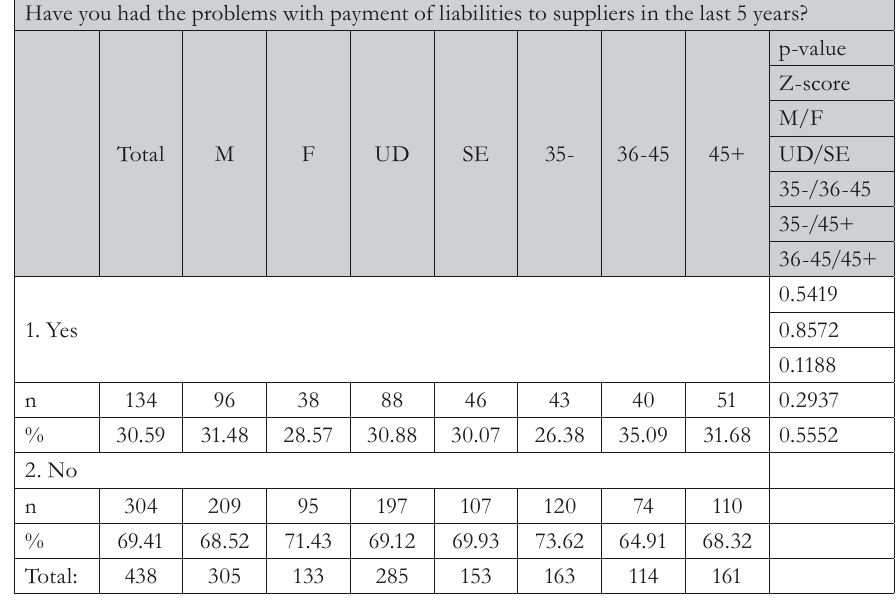
Tab. 4 – The problems of SMEs with payment of their liabilities. Source: own processing Have you had the problems with payment of liabilities to suppliers in the last 5